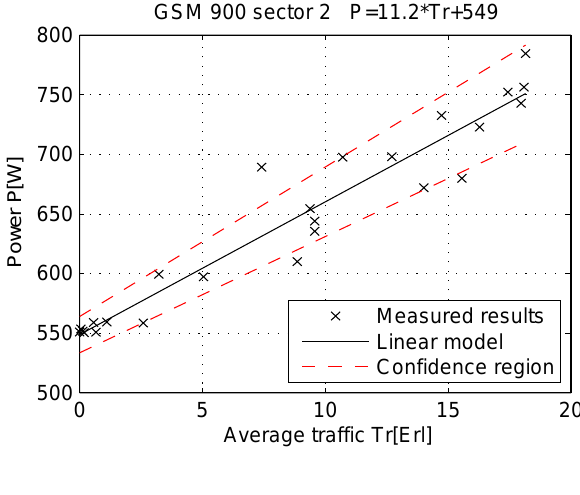
Figure 32. Power consumption model of GSM 900 sector 2 BS rack (Monday,